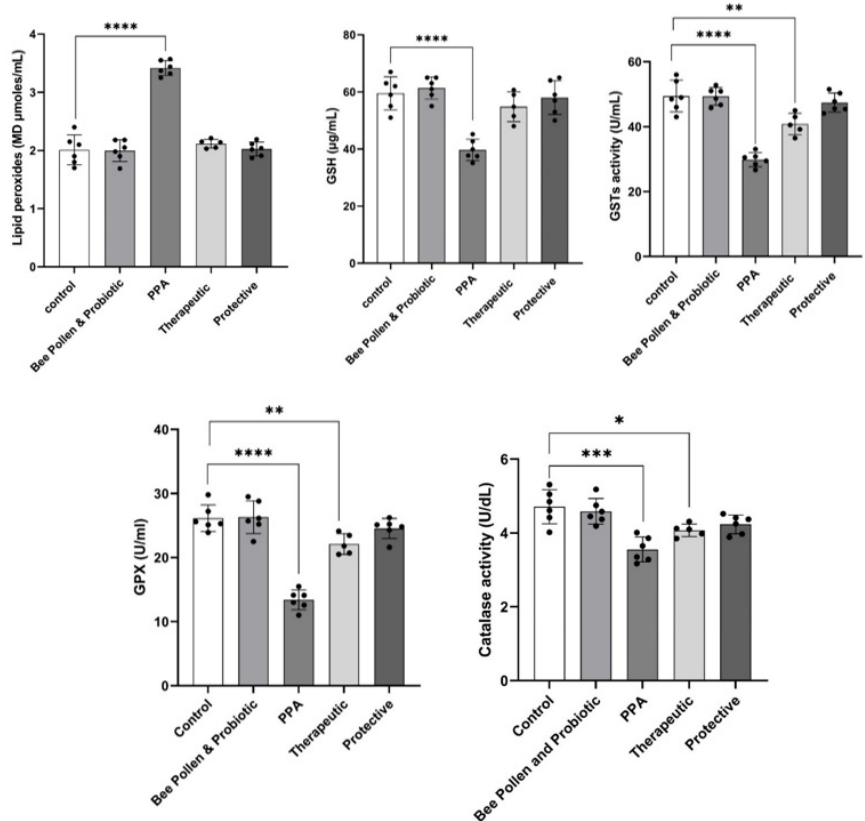
Figure 1. Effect of PPA treatment, protective, and therapeutic effects of bee pollen/probiotics on serum oxidative stress-related variables. Data presented are means ± standard error. Multiple comparisons by Tukey’s post hoc test * p ≤ 0.050, ** p ≤ 0.01, *** p ≤ 0.001, **** p ≤ 0.0001. GSH, glutathione; GPX, glutathione peroxidase, GST, glutathione-S-transferase; PPA, propionic acid. Figure 2 demonstrates the same trend in relation to intestinal permeability measured biomarkers ( p ≤ 0.0001). While zonulin and occludin were signi fi cantly higher in PPA- treated rats (1.91 ± 0.13 ng/mL and 1.23 ± 0.15 ng/mL, respectively), compared to the con- trol group (0.51 ± 0.05 ng/mL and 0.20 ± 0.03 ng/mL, respectively), showing gut leakiness, demonstrated zonulin levels of 0.82 ± 0.12 ng/mL or 0.55 ± 0.05 ng/mL and occludin levels